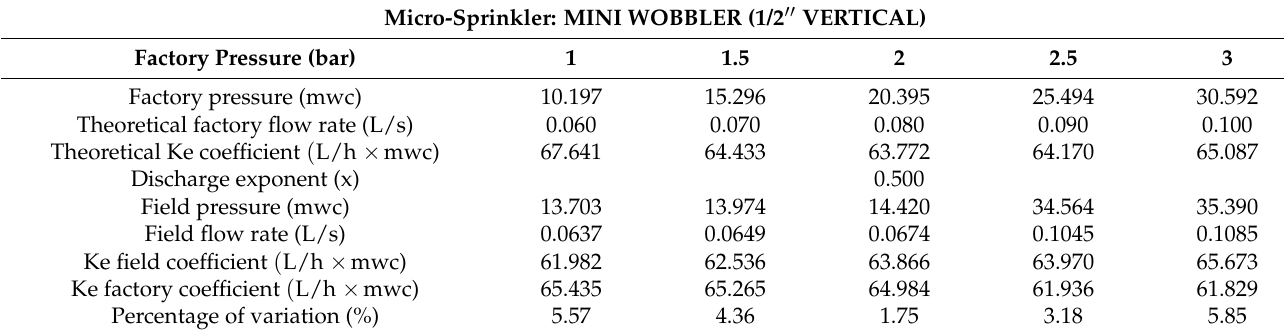
Table 2. Ke discharge coefficients of Mini Wobbler micro-sprinkler (1/2 (cid:48)(cid:48)